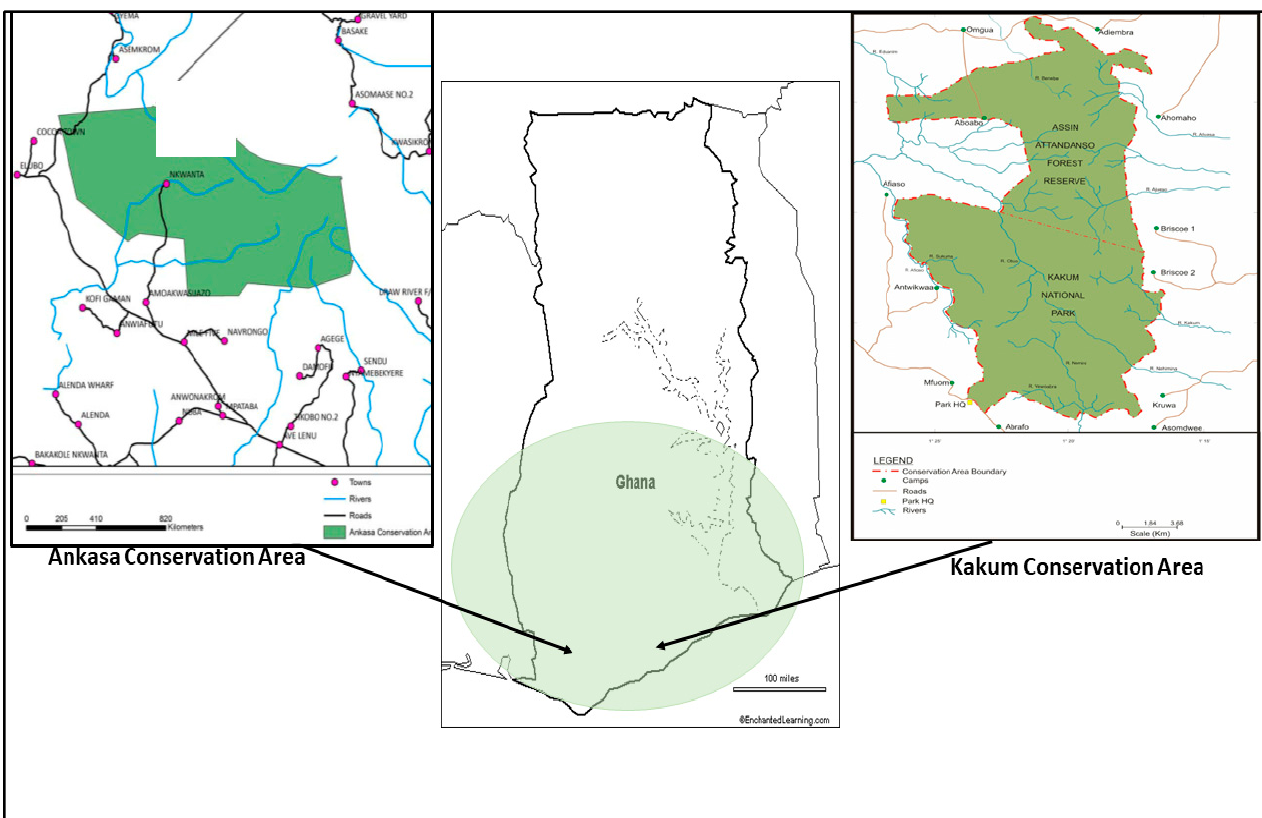
Figure 1. Overview of the two study sites in Ghana. The green area in the map of Ghana illustrates the high-forest zone, with left and right dark arrows pointing to the approximate locations of Ankasa and Kakum conservation areas in the south-western and central regions, respectively. Source: Based on Asaaga and Hirons [8].